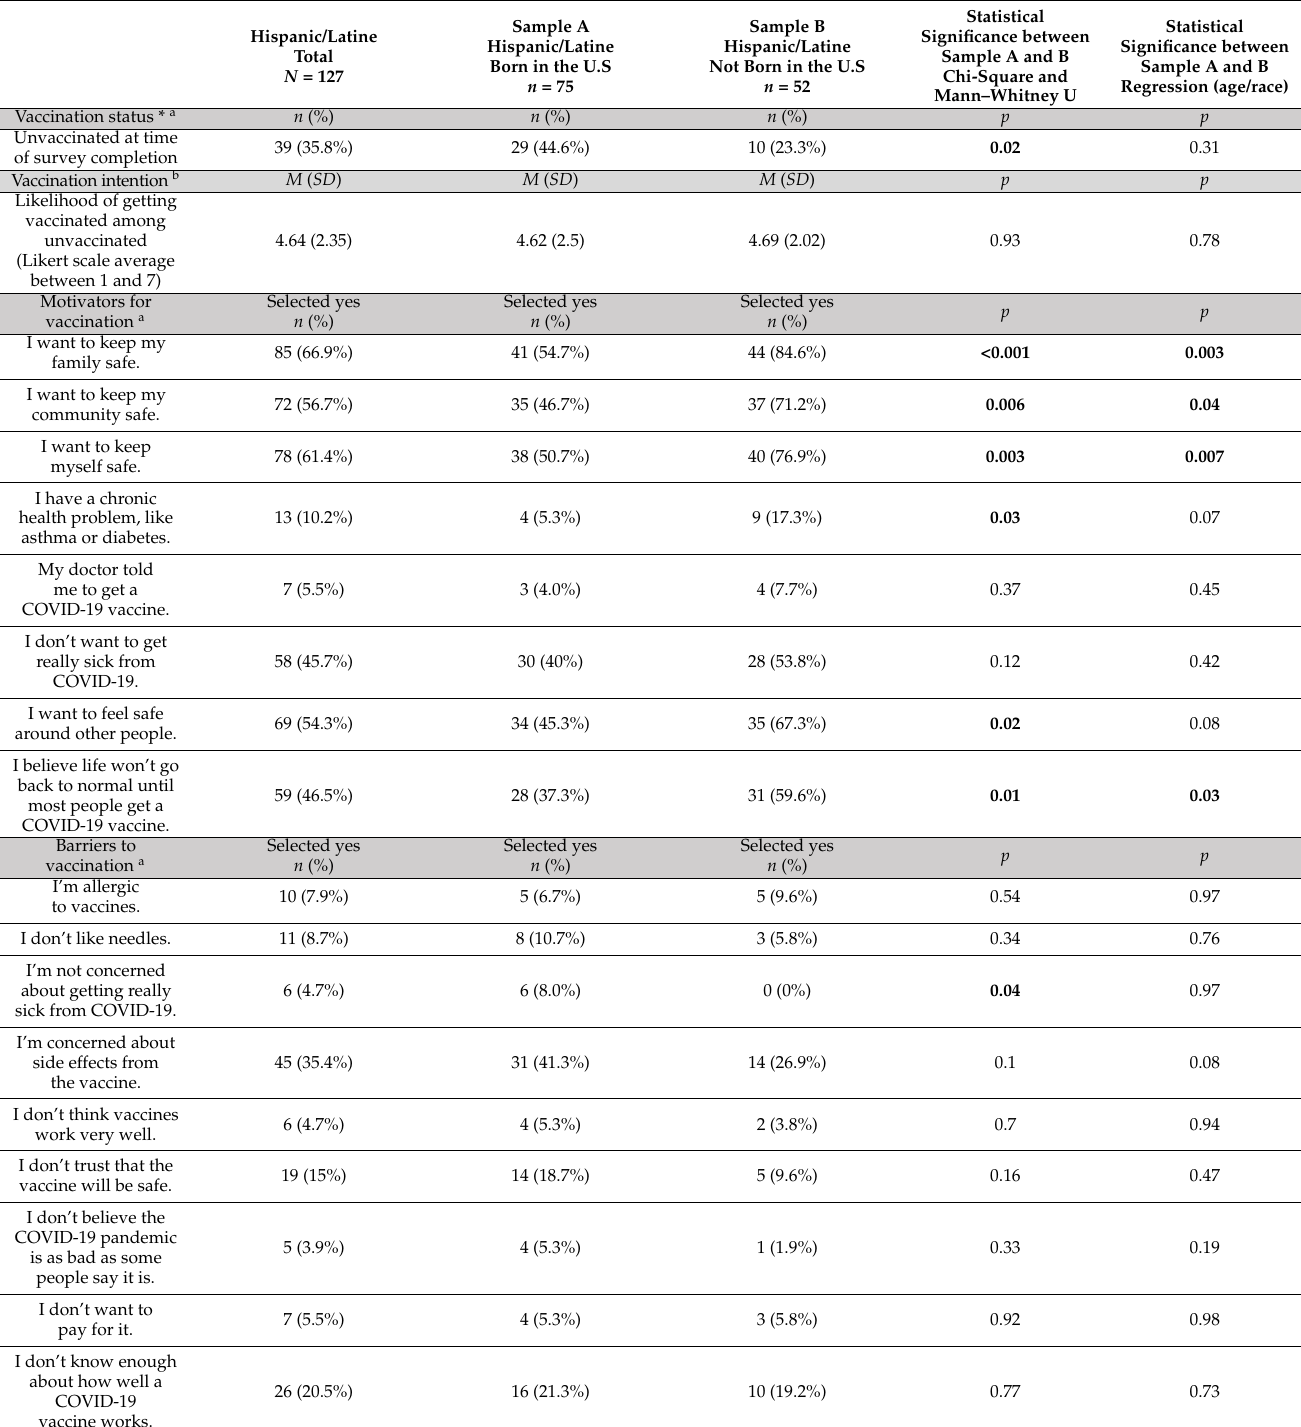
Table 2. Chi-square and regression analyses comparing participants born in the U.S. vs. not born in the U.S. Sample A Hispanic/Latine Born in the U.S N = 127 n = 75